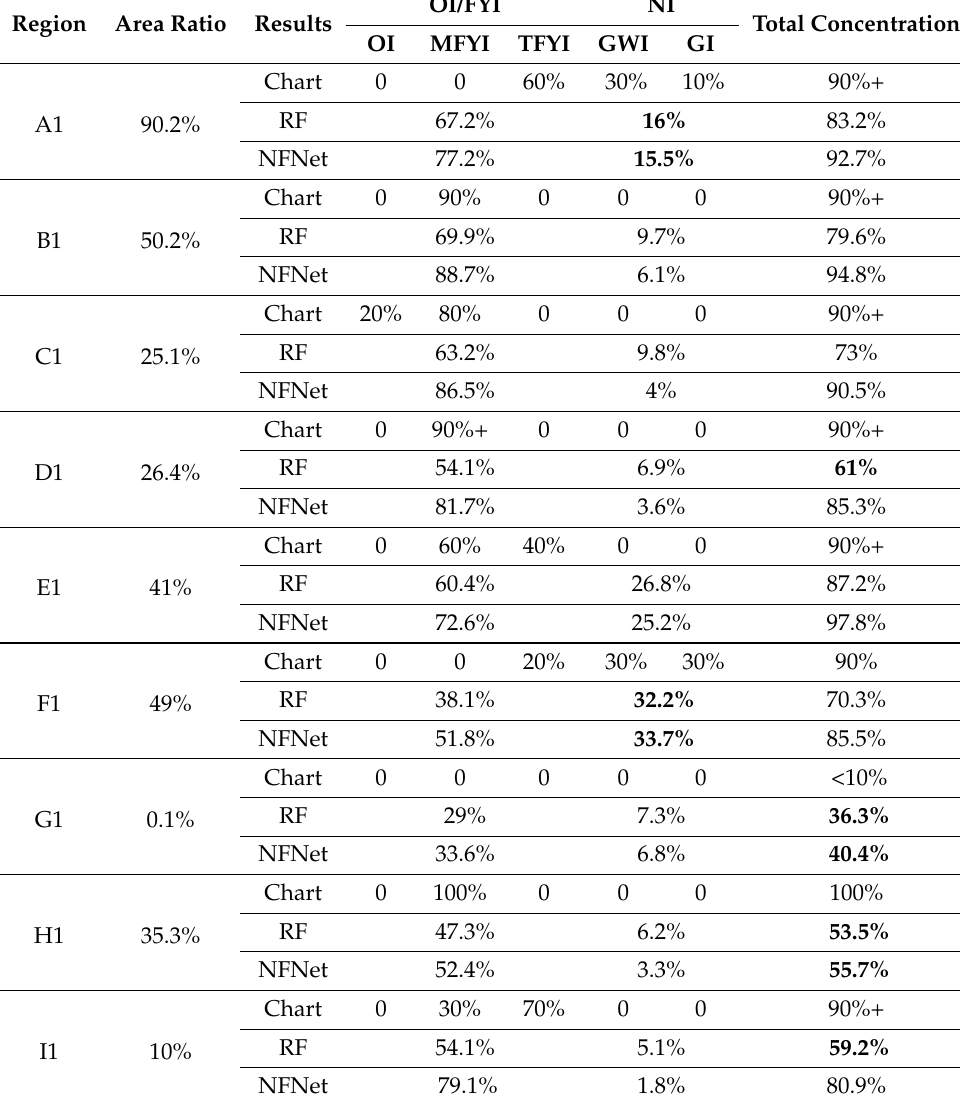
Table 5. Comparison of the estimated concentration for 1